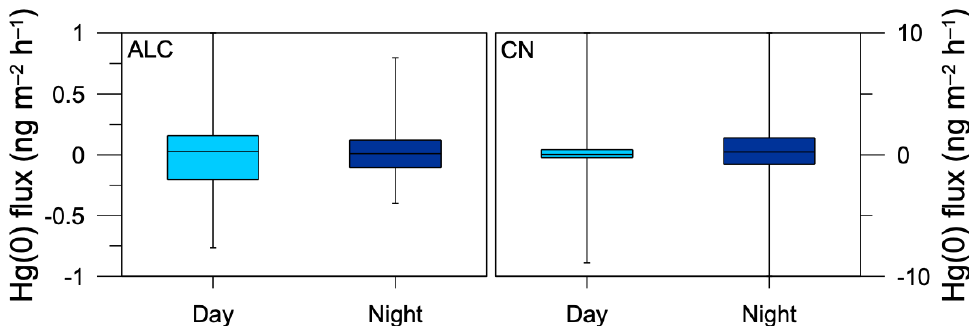
Figure 9. Vegetation–air Hg(0) fluxes (ng m −2 h −1 ) during the day and night periods in saltmarsh areas of the background site ALC and the industrial site CN.